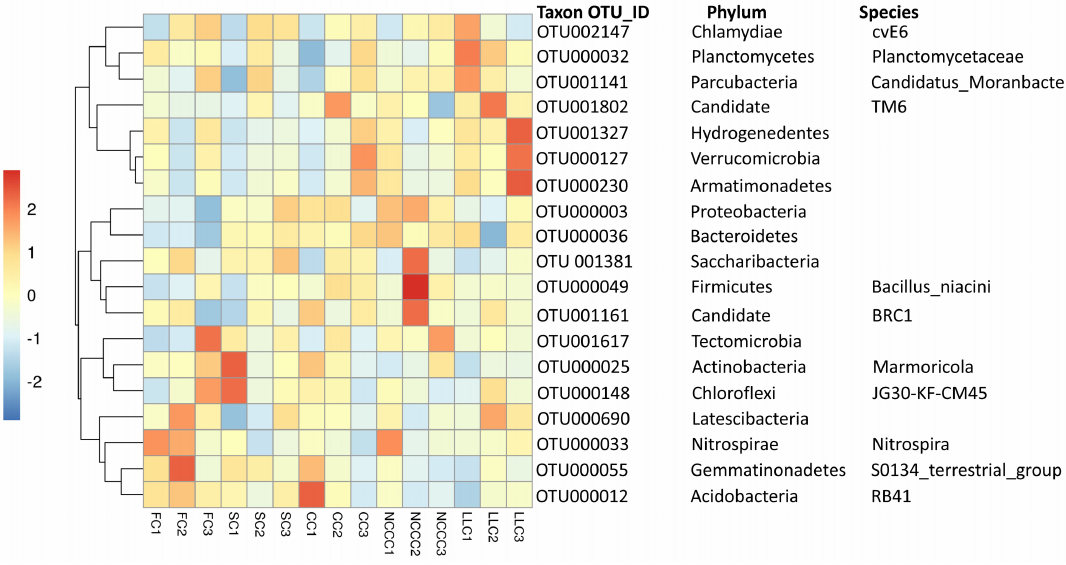
Figure 2. Heatmap analysis of abundant bacterial taxon under di ff erent planting